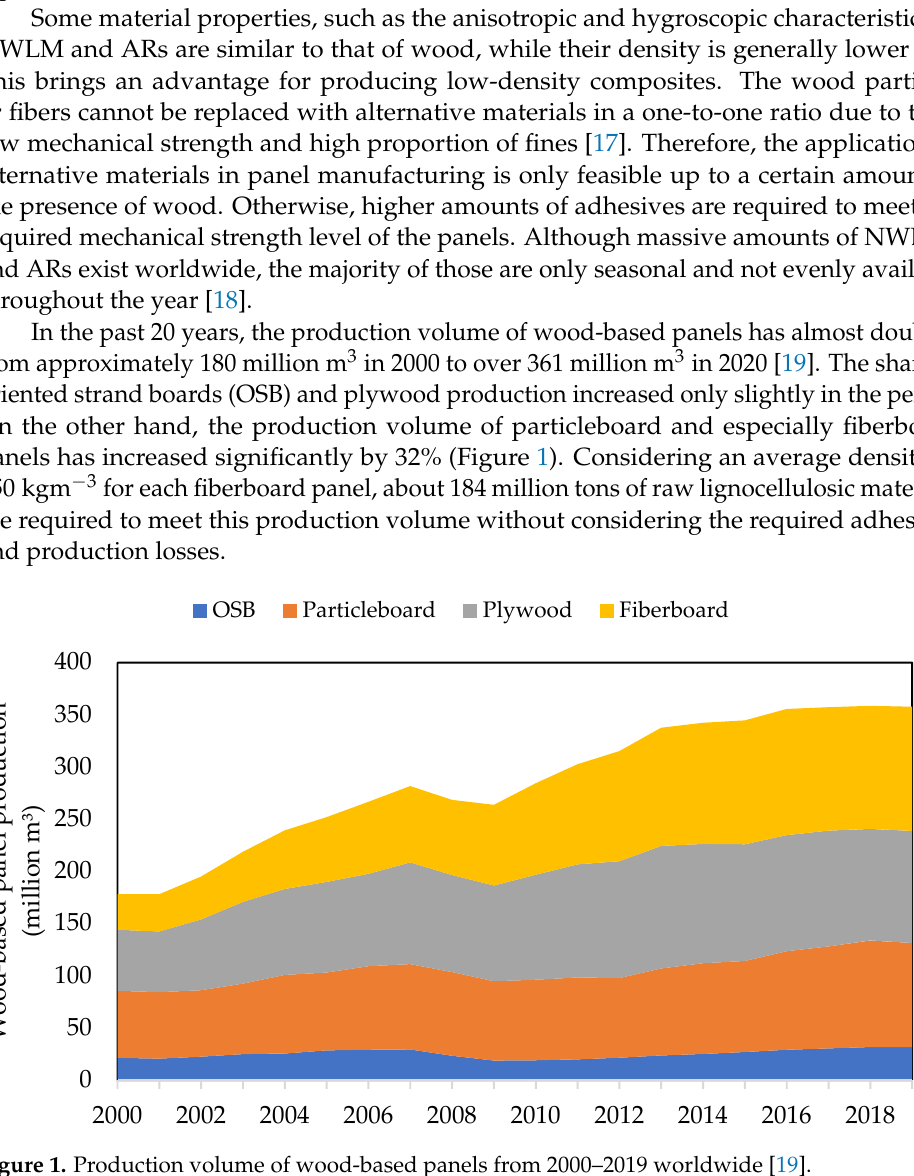
Figure 1. Production volume of wood-based panels from 2000–2019 worldwide